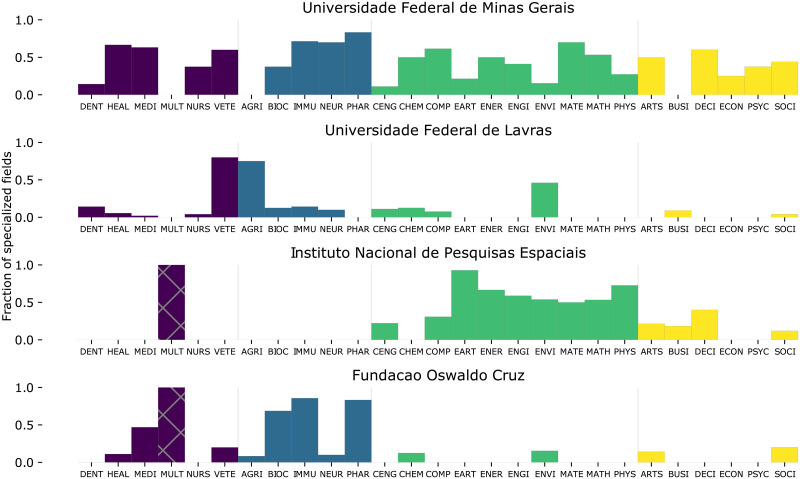
Institutions specializations.Fraction of subfields in each of the intermediate fields in which some of the institutions are specialized (data from the time interval [2000, 2014]). Intermediate classifications are grouped and colorcoded according to the macro field. The Multidisciplinary (MULT) intermediate field has only a single subfield and is then shown with hatches.